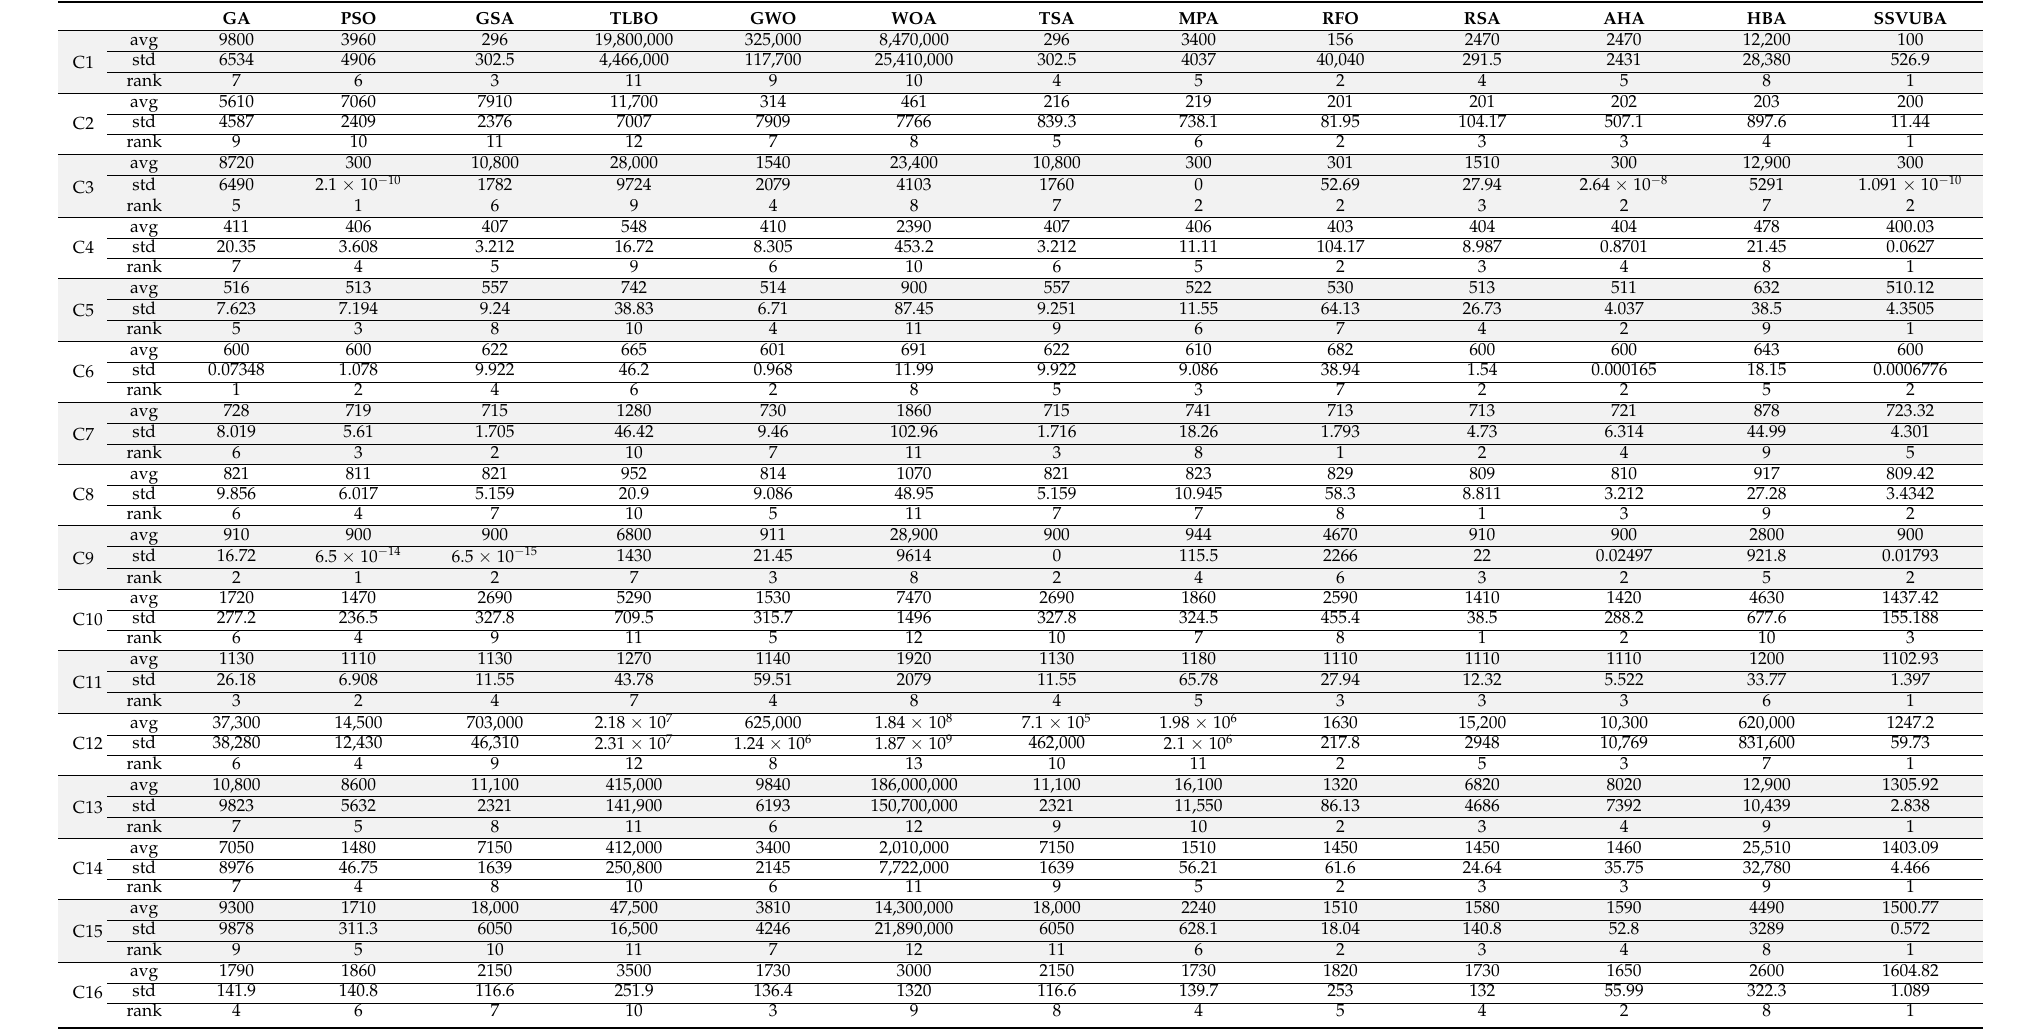
Table 9. Assessment results of the CEC 2017 test